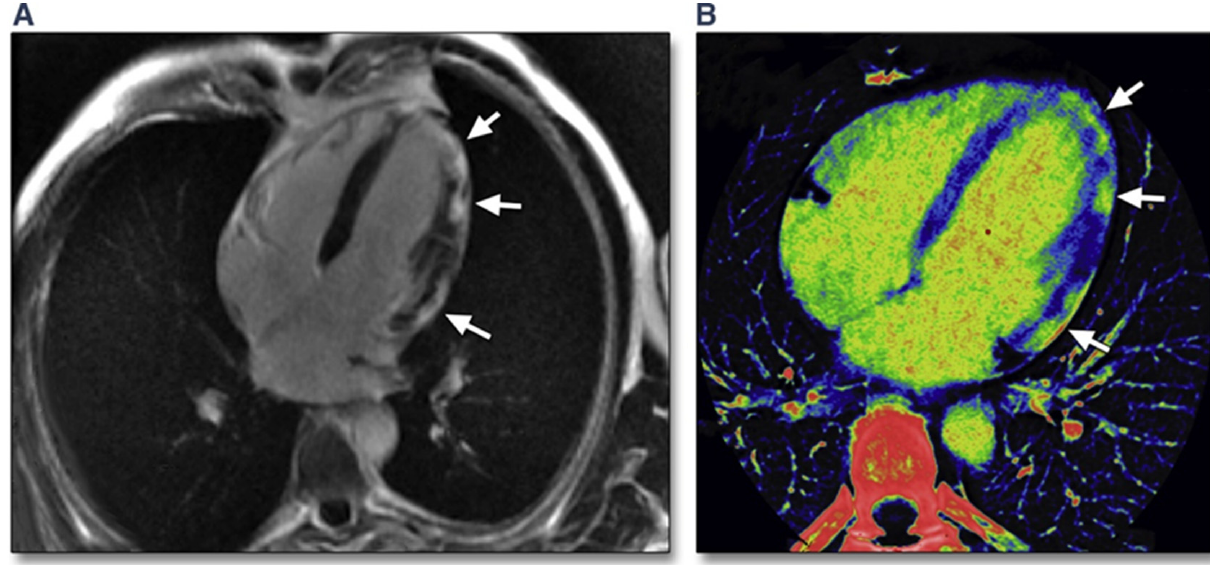
Figure 2. CMR and cardiac spectral CT imaging. ( A ) Late gadolinium enhancement imaging on cardiac magnetic resonance (CMR) in a 4-chamber view that reveals subepicardial myocardial inflammation involving the lateral and apical walls (arrows). ( B ) Corresponding spectral computed tomographic (CT) imaging with late iodine enhancement (arrows). From: Bouleti C, Baudry G, Iung B, et al. Usefulness of Late Iodine Enhancement on Spectral CT in Acute Myocarditis. JACC Cardiovasc Imaging. 2017, 10(7), 826-827. Reprinted with permission from Elsevier [38].